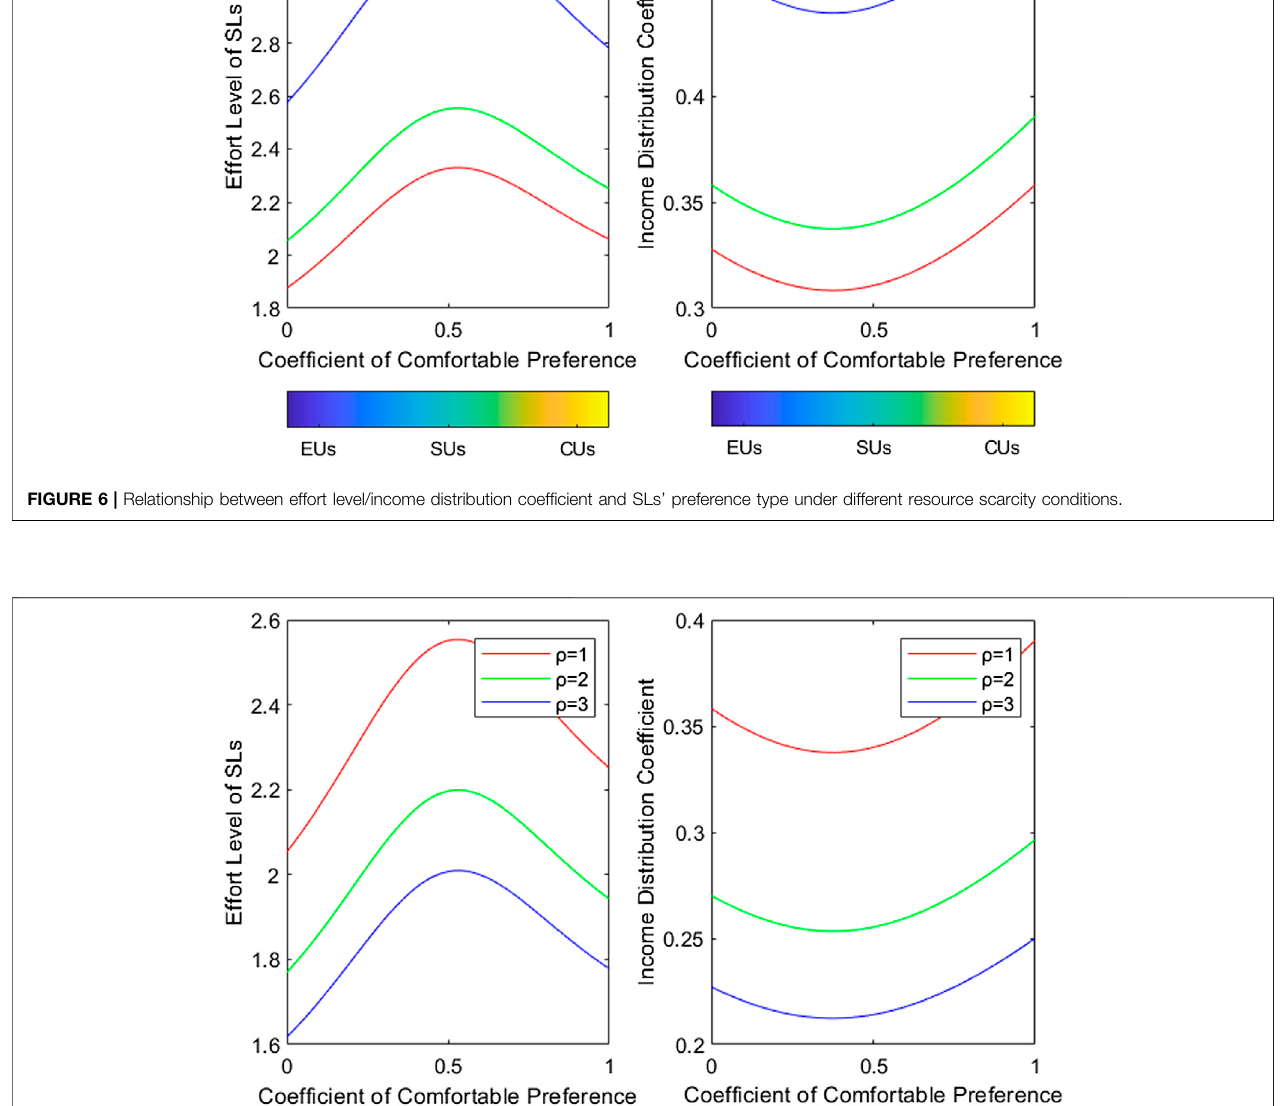
Step 1: Enter the current heating room temperature of all SLs, the preference of each SL, and the temperature scheduling interval corresponding to different preferences. Step 2: Determine and calculate the temperature that the ith SL can reduce.